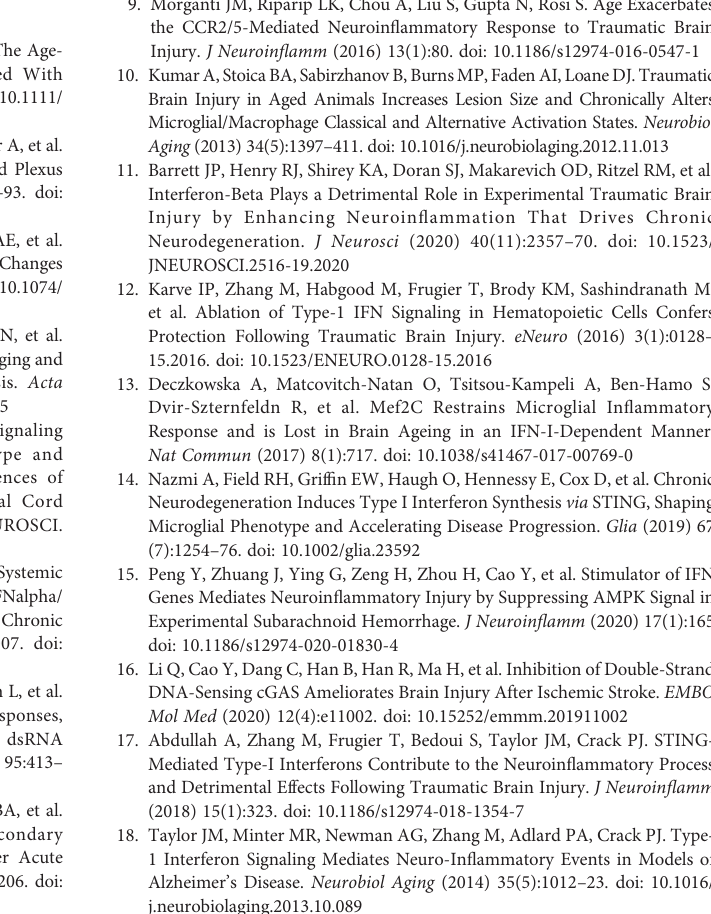
Supplementary Figure 1 | Venn diagram of the number of genes with signi fi cantly altered expression between study groups by NanoString Diff fold- changeanalysis. Bluecircle depictsthe totalnumberofgenesthat weresigni fi cantly altered in the comparison of Young Sham (YSham) vs Young TBI (YTBI). Yellow circle shows the total number of genes signi fi cantly altered in the comparison of Aged Sham (ASham) vs Aged TBI (ATBI). Green circle shows genes that were signi fi cantly altered in the comparison of Young TBI vs Aged TBI. A total of 193 genes were altered by TBI compared to Sham ( Supplemental Table 4 ), with the majority (137) altered by TBI in both young and aged animals. For other divisions within the Venn, the genes within each group are designated as follows: # = C7, Ccl20, IL23a; *= Nox4, Ccl5; ¶ = Aire, Camp, Cxcl13, Ifna1, II5, Marco, Pdcd1; & = Defb1,